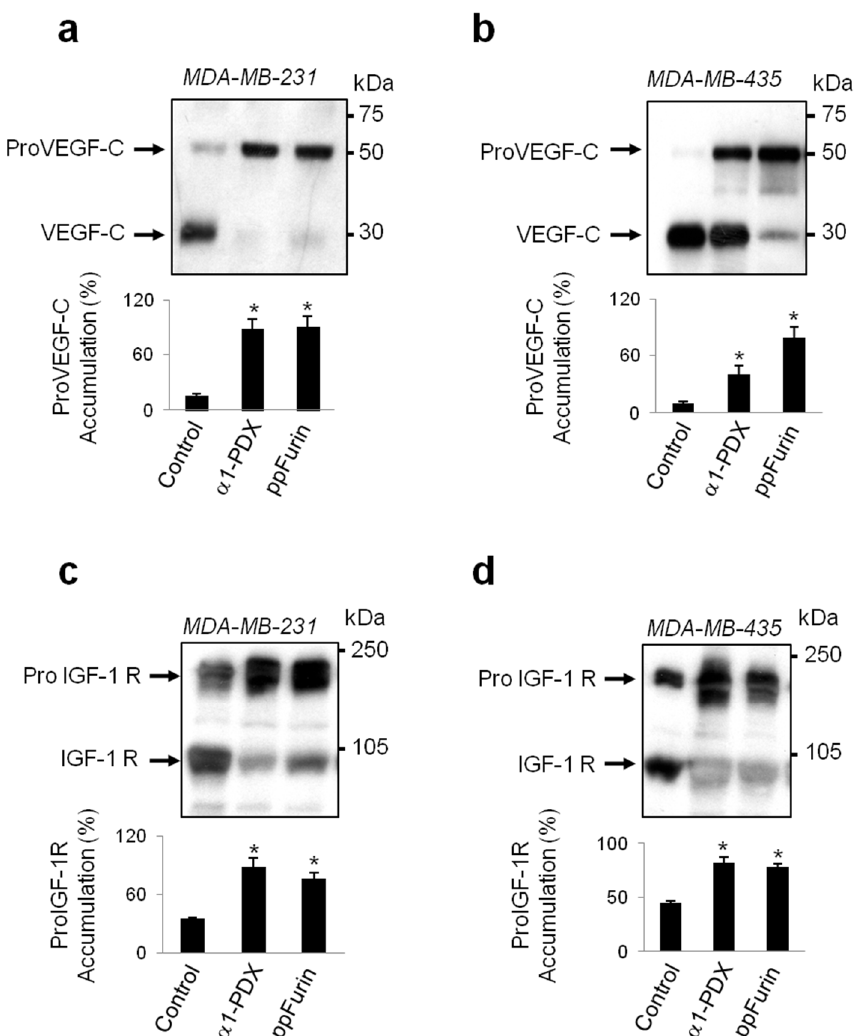
Figure 2. Inhibition of vascular endothelial growth factor C (proVEGF-C) and insulin-like growth factor-1 receptor (proIGF-1R) by ppFurin in breast MDA-MB-231 and melanoma MDA-MB-435 cell lines. Western blotting for proVEGF-C precursor and its mature form ( a , b ) and for proIGF-1R precursor and its mature form ( c , d ) expression. Effect of the general PC-inhibitor α 1-antitrypsin Portland ( α 1-PDX) on proVEGF-C and proIGF-1R cleavage is given for comparison. Bar graphs indicate the percentages of proVEGF-C and proIGF-1R accumulations in the absence and presence of ppFurin or α 1-PDX. All values are presented as means ± SEM of three independent experi- ments. Statistical significance was assessed by t -test and * represents p < 0.05 as compared to the corresponding controls.